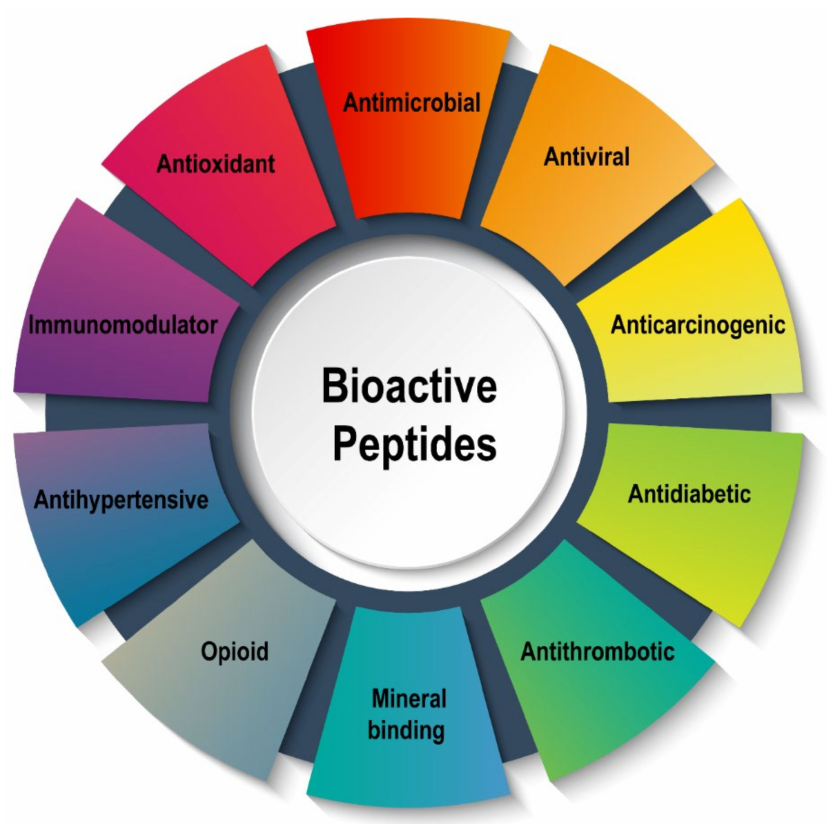
Figure 1. Schematic representation of various types of bioactive peptides from food proteins. Free radicals or ROS with high energy, especially hydroxyl radicals, can interact with all 20 amino acids. However, the imidazole-containing amino acid (His), aromatic amino acids (Tyr, Phe, and Trp), and nucleophilic sulfur-containing amino acids (Met and Cys) demonstrated the most reactivity [67]. Non-enzymatic and enzymatic (lipoxygenase- mediated) peroxidation of essential fatty acids and lipids has been retarded by the different BPs derived from food [68,69]. Singlet oxygen quenching, free radical scavenging, and metal ion chelation are possible mechanisms of antioxidant properties of these